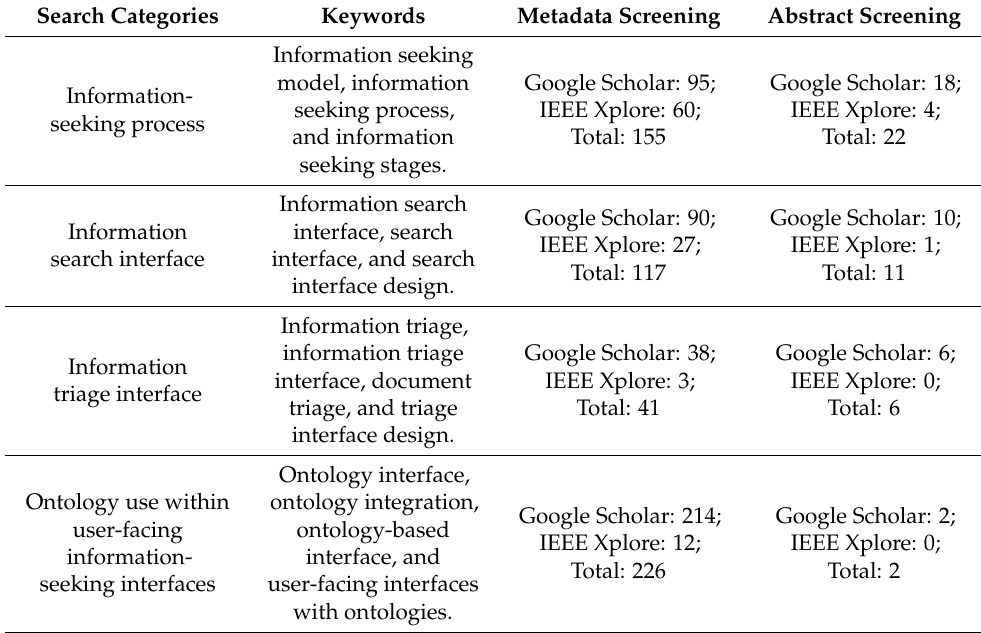
Table 1. Search categories, keywords used to identify literature, and screening results reflected as the number of articles